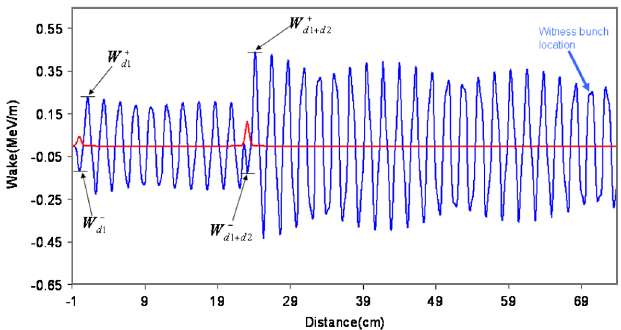
FIG. 6. Simulation of the longitudinal wake potential of the two-bunch RBT. Drive bunches are shown in red and the wake is in blue. In the plot, W þ d 1 and W þ d 1 þ d 2 represent maximum accel- erating fields behind the first and the second drive bunch, respectively, in the two-bunch RBT case. W (cid:1) d 1 ¼ W (cid:1) d 1 þ d 2 repre- sent maximum decelerating fields inside the first and the second drive bunch,